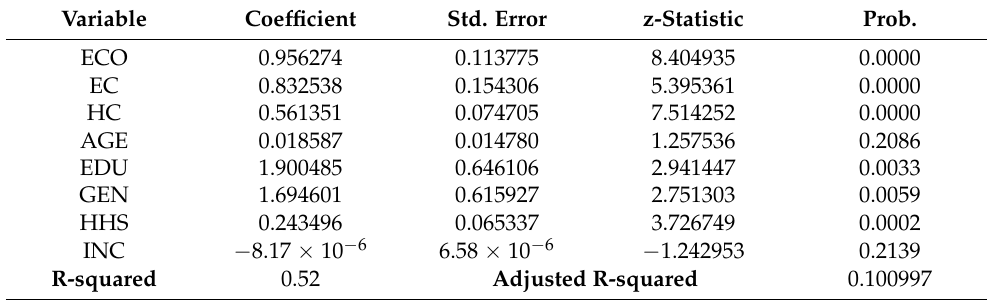
Table 3. Regression analysis.